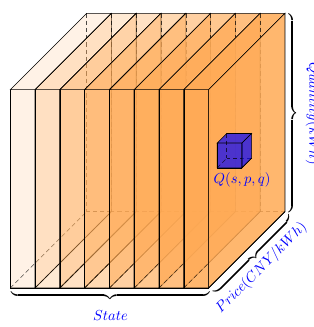
Figure 6. A Q-cube framework designed for the Q-learning